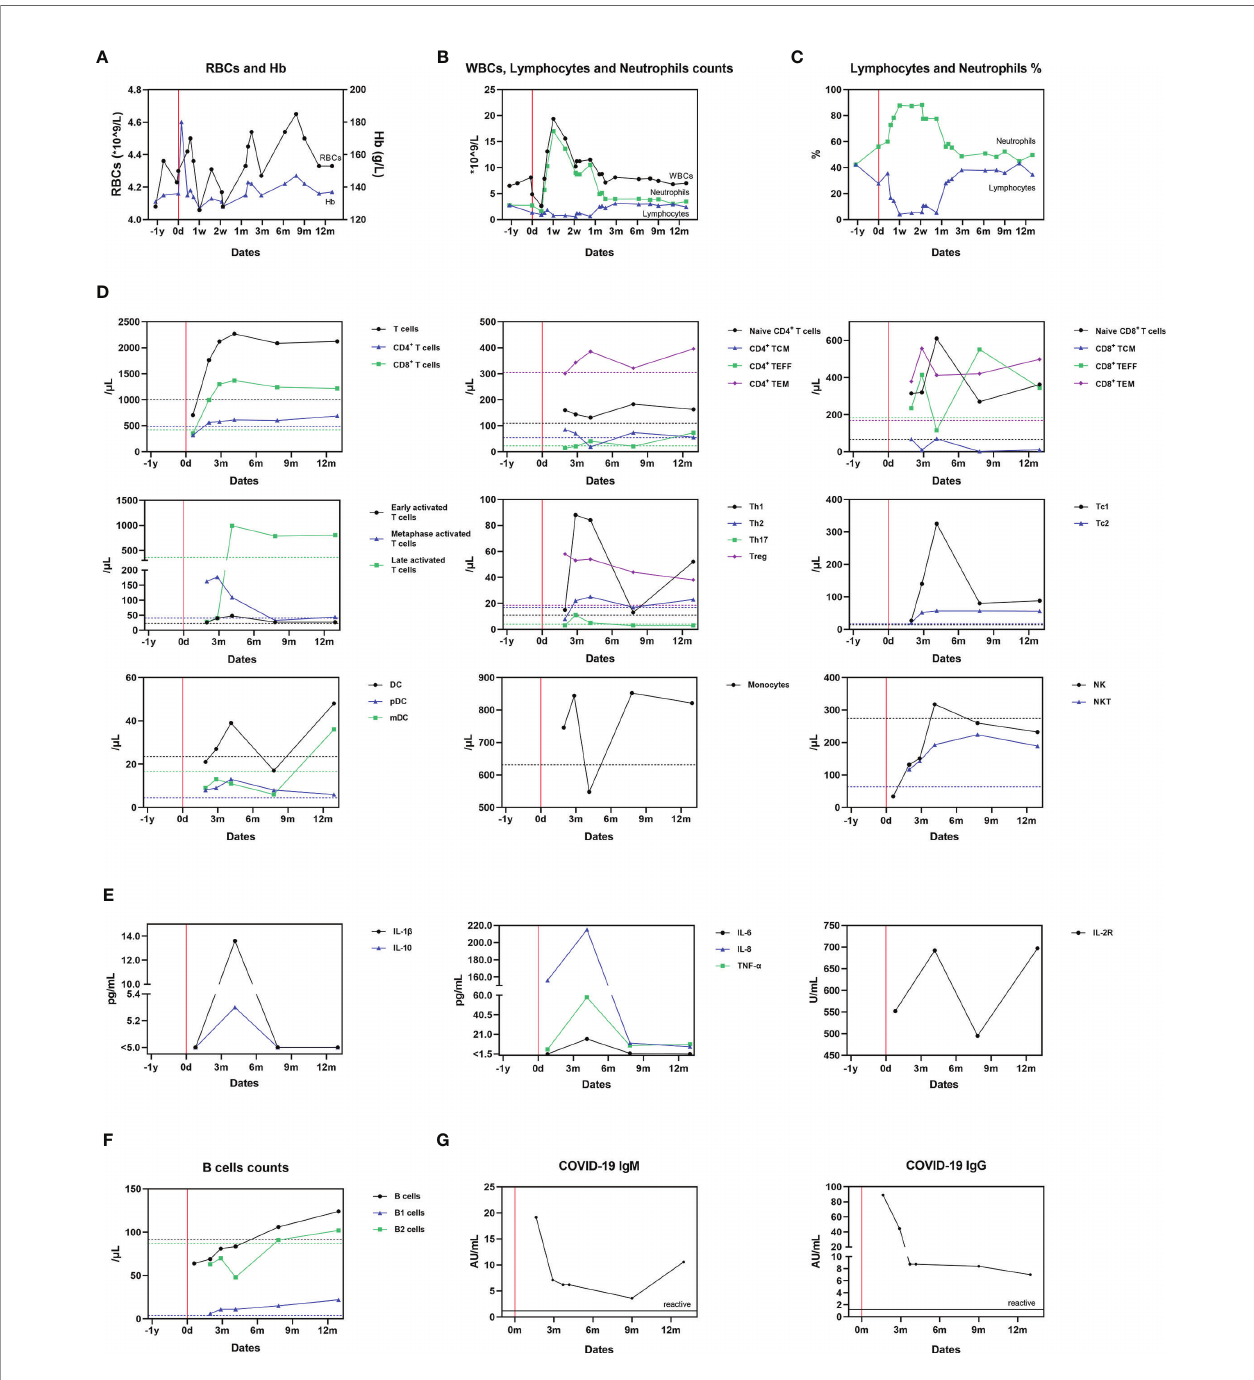
FIGURE 3 | Dynamic changes of cellular and humoralimmunity after SARS-CoV-2 infection. (A) Serum RBCs and Hb measurements; (B) Serum WBCs, lymphocyteand neutrophilcounts; (C) Serum lymphocytes and neutrophils proportions; (D) The proportion of immunocytes; (E) Cytokines levels; (F) B cellcounts; (G) Antibodies against SARS-Cov-2. The mean value derived from two uninfected paired controls isshown usingdotted lines as a comparator in (A –